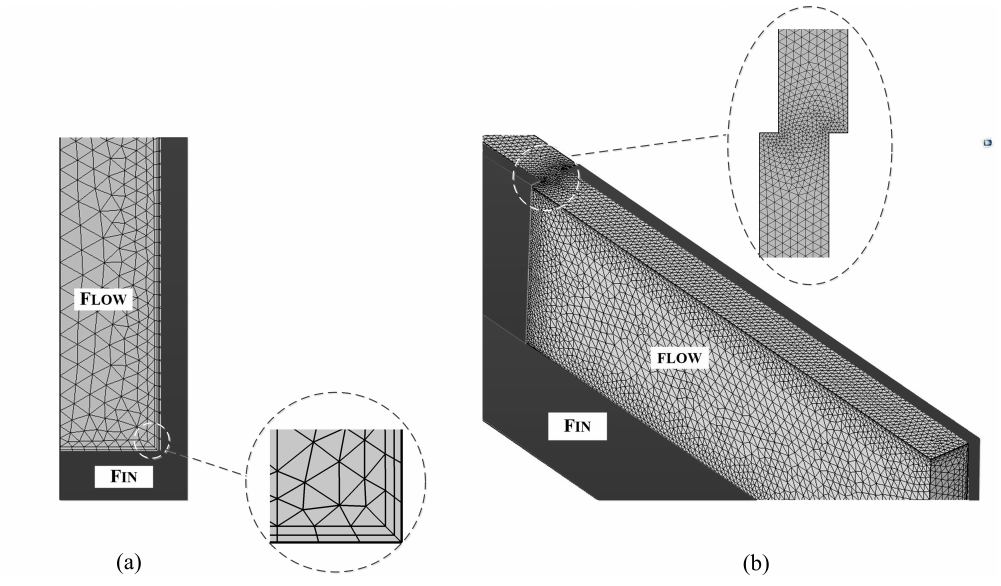
Figure 5. Mesh configuration to simulate the flow in the heatsink ( a ) Adjacent to boundary layers, ( b ) In sharp